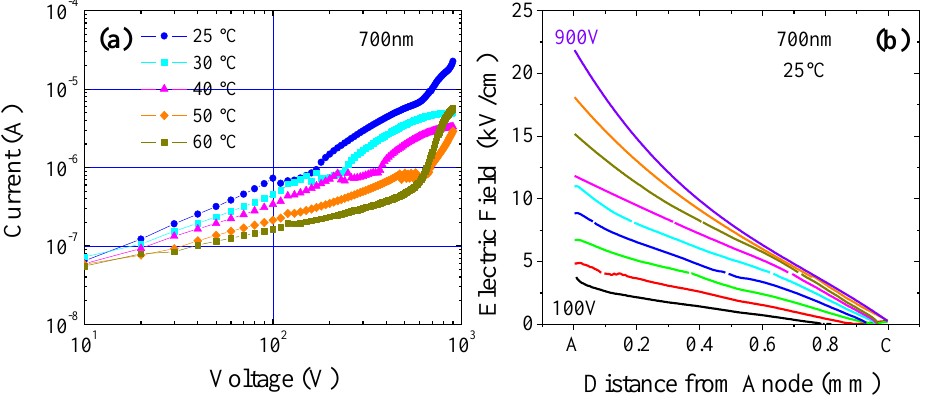
Figure 8. Optical irradiation at 700 nm on the cathode side: ( a ) Photocurrent at different temperatures. ( b ) Electric field profiles at different voltages, at 25